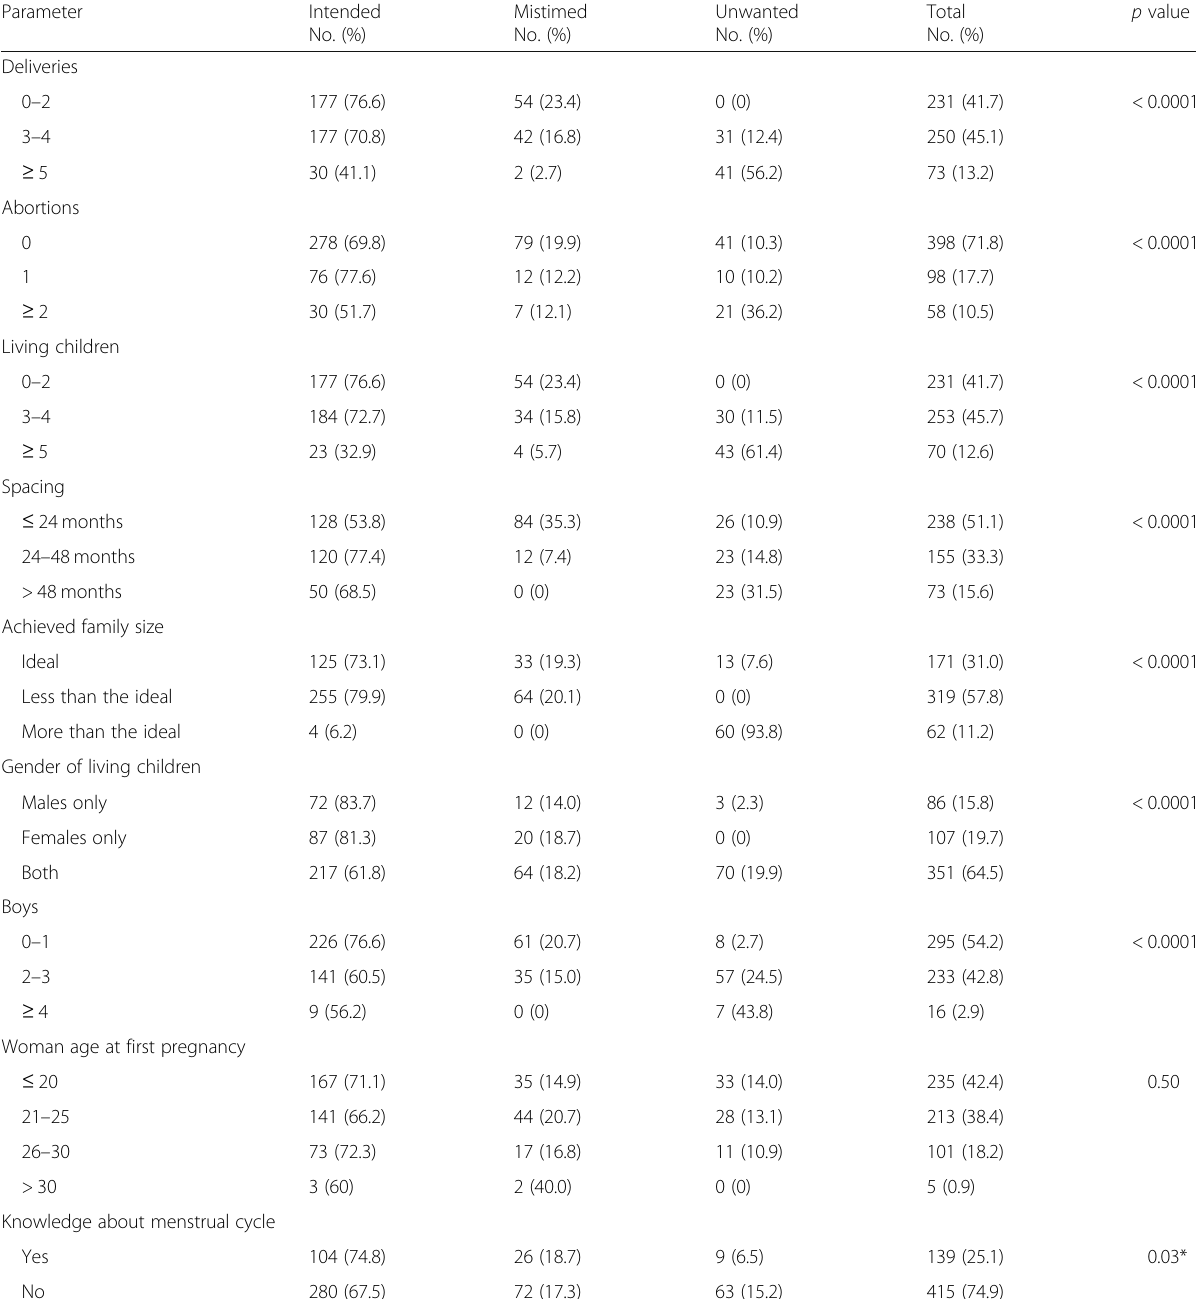
Table 2 Pregnancy intention status in relation to some women ’ s reproductive variables, Sohag district, Egypt, 2016